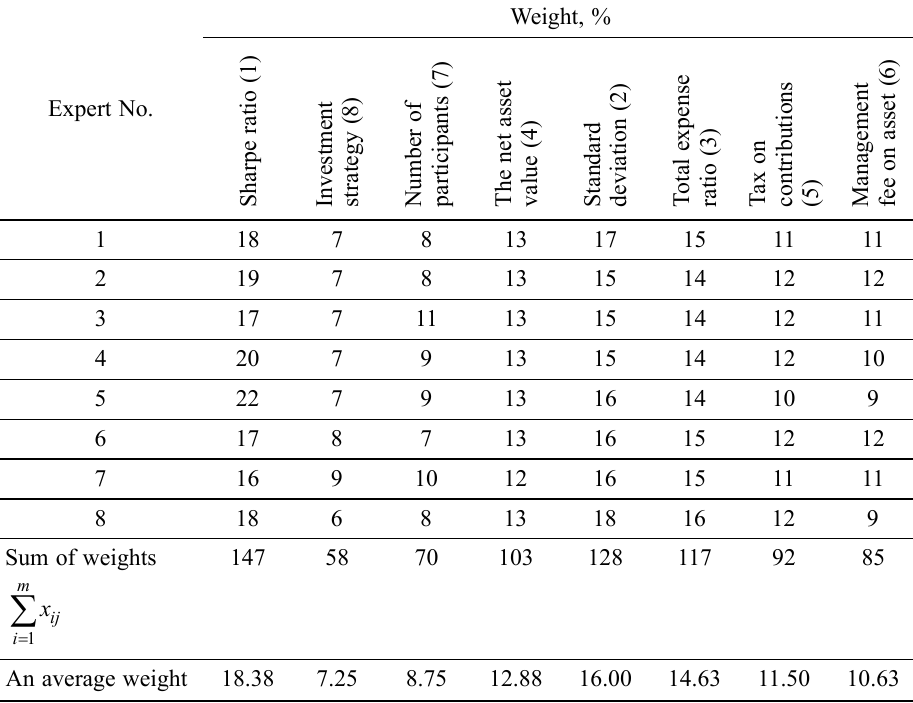
Table 3. Data of expert assessment and weighing results of the 3 rd pillar PF evaluation criteria